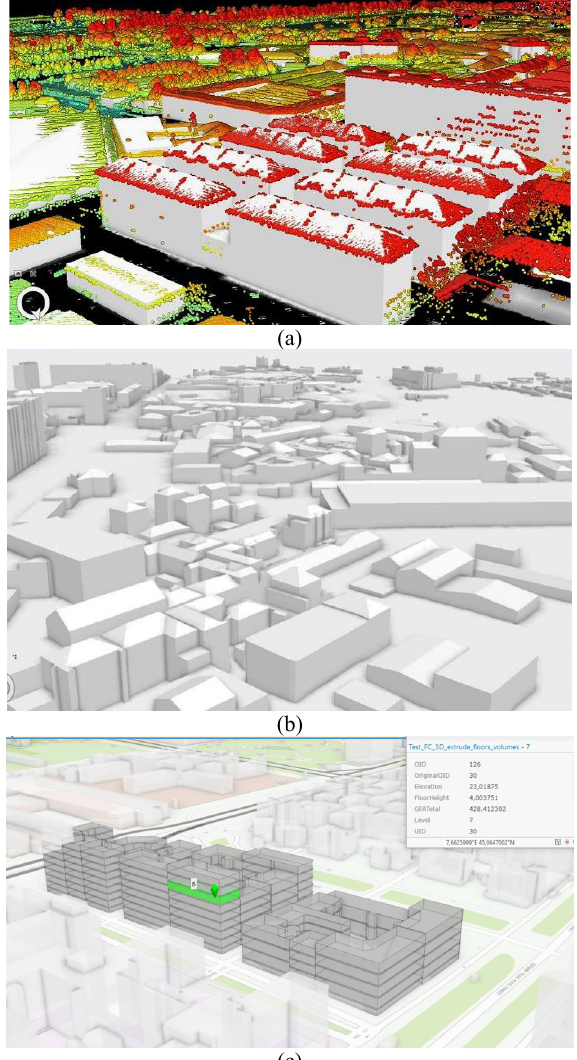
Figure 3. The Torino 3D city model structure: (a) LoD2 extraction from Lidar DSM; (b) LoD2 from footprint, height and roof shape; (c) floors elements